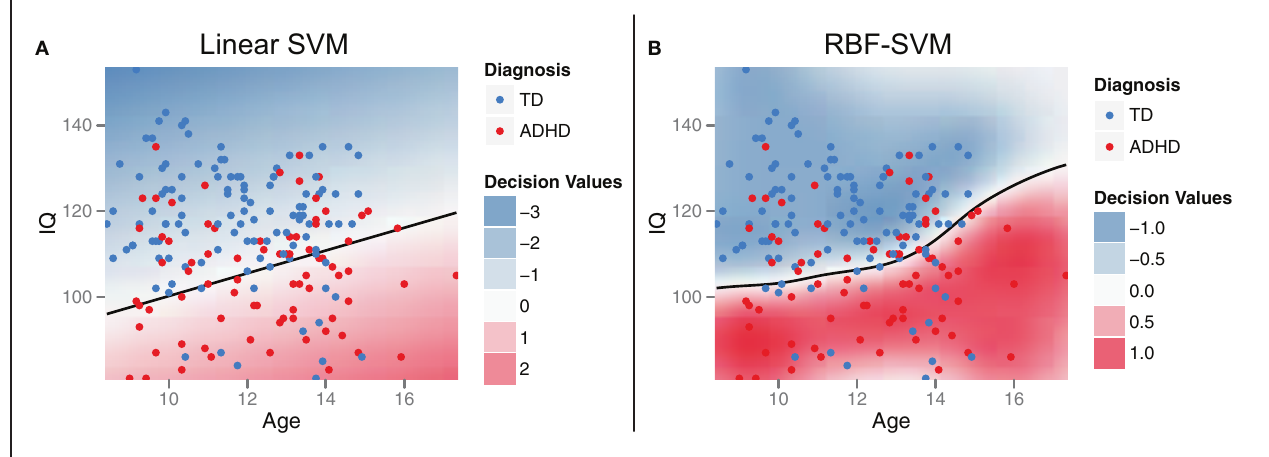
FIGURE 2 | Supportvector machines (SVM). Support vector machines identify aclassification decision boundary (shown as ablack line) that maximizes the margin (i.e., Euclidean distance) to the nearest training cases of either class, subject to amisclassification penalty. In linear SVM (A) , this